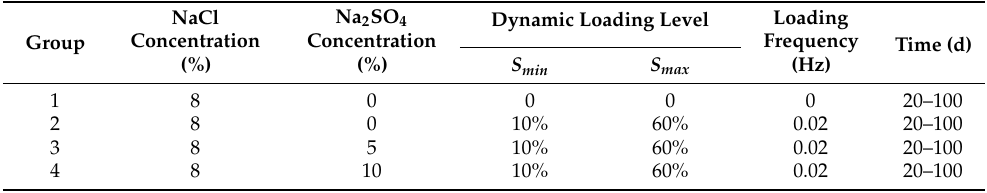
Table 3. Experimental program of the concrete chloride ion erosion under the coupling condition of the cyclic load and dual